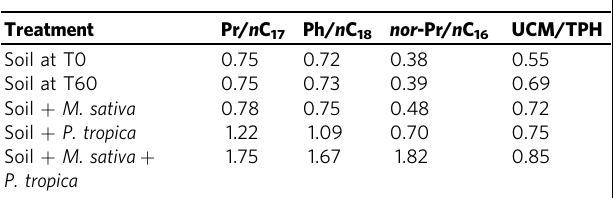
(Supplementary Table 2). Similarly, P. tropica isolates possess the highest number of genes encoding phosphatases, siderophore exporter and indoleacetic acid synthase. Previous studies have shown that these enzymes and active peptides are vital for phosphate